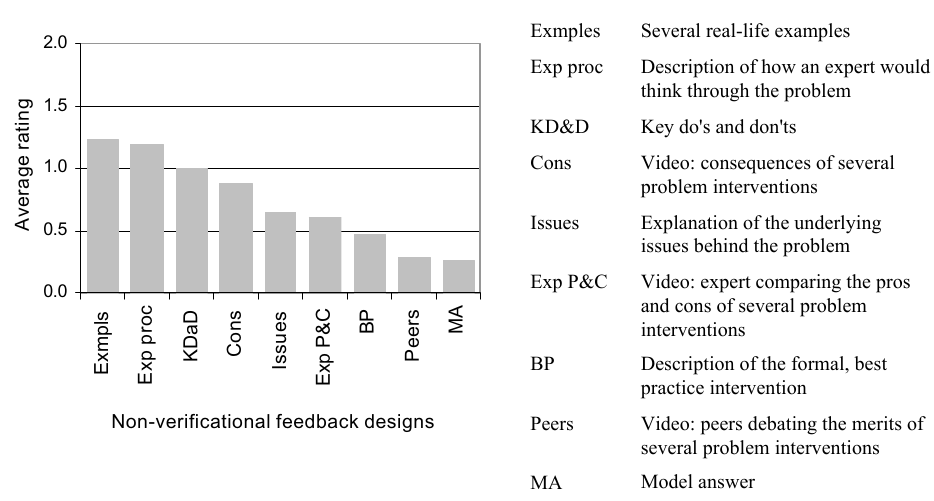
Figure 1. Averaged and ranked interviewee ratings for hypothetical non-verificational feedback designs ( n =